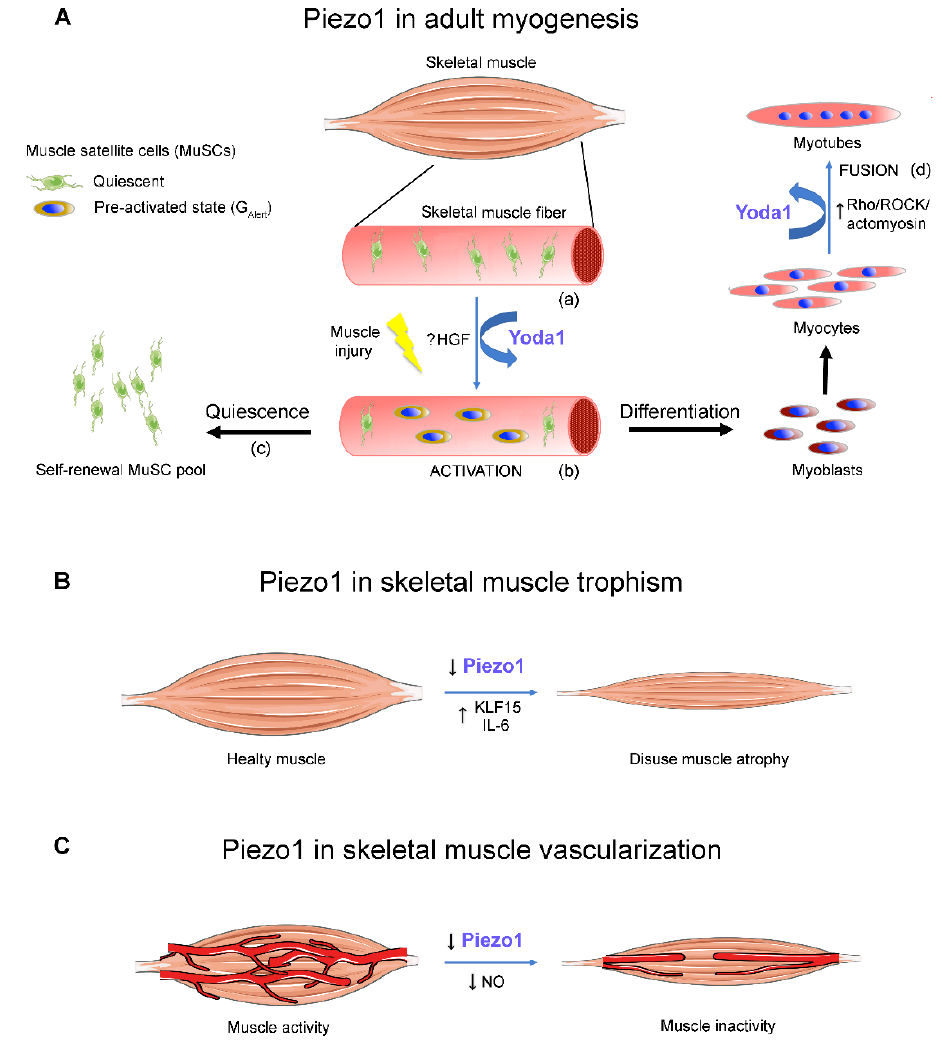
Figure 1. Role of Piezo1 in skeletal muscle. ( A ), Piezo1 controls the adult myogenesis. ( a ) Quiescent satellite cells (MuSCs) are located on intact muscle fibers. ( b ) Under muscle injury or following the Piezo1 activation by Yoda1, the MuSCs shift toward a G Alert phase favouring the cell activation. ( c ) Part of the MuSCs self-renews the quiescent population; ( d ) the rest proliferates as myoblasts, differentiate into myocytes, which then fuse into multinucleated myotubes. The pharmacological activation of Piezo1 by Yoda1 promotes myocyte fusion and myotube differentiation. ( B ), A down regulation of PIEZO1 expression leads to disuse atrophy of the adult muscle. ( C ), The stimulation of the Piezo1 activity of endothelial cells and muscle cells during physical exercise sustain angiogenesis and muscle trophism.